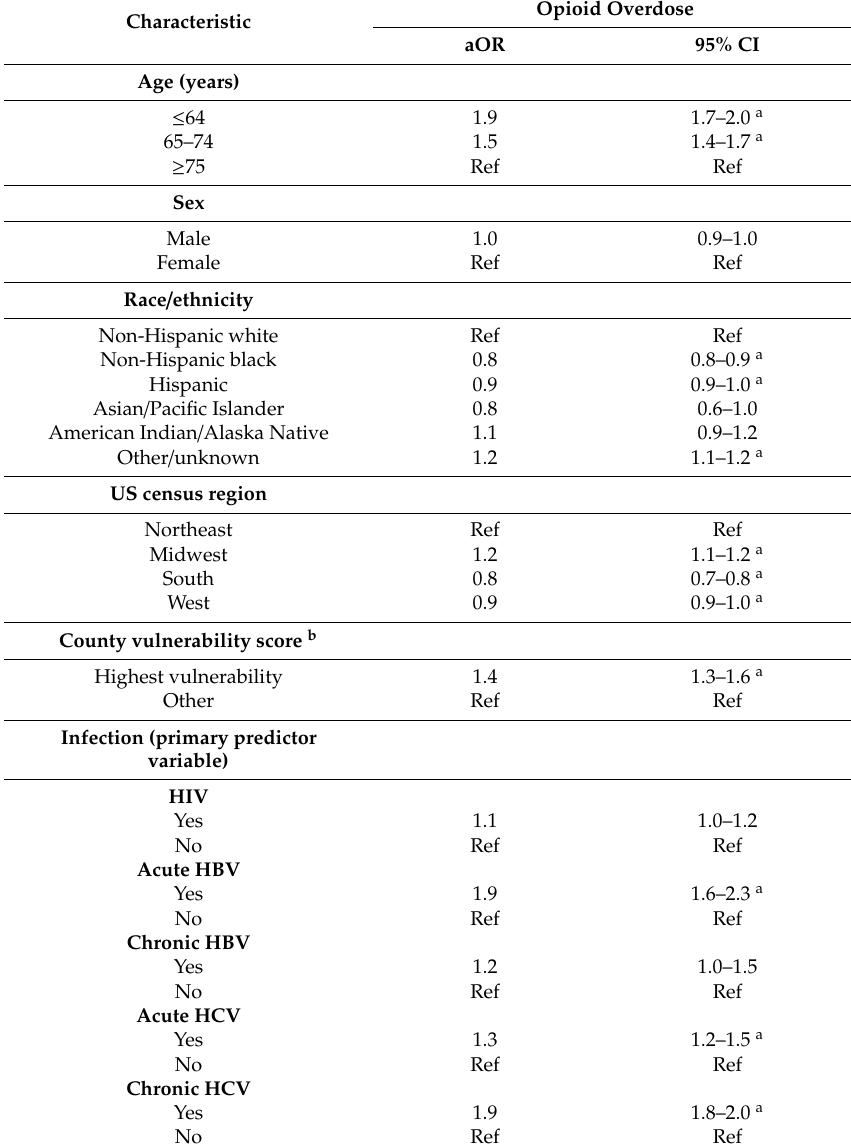
Table 4. Adjusted odds ratios (aORs) and 95% confidence intervals (CIs) for association of opioid overdoseclaimswitheachdemographicattributeofMedicarebeneficiarieswithclaimsforopioid-related diagnoses, United States,